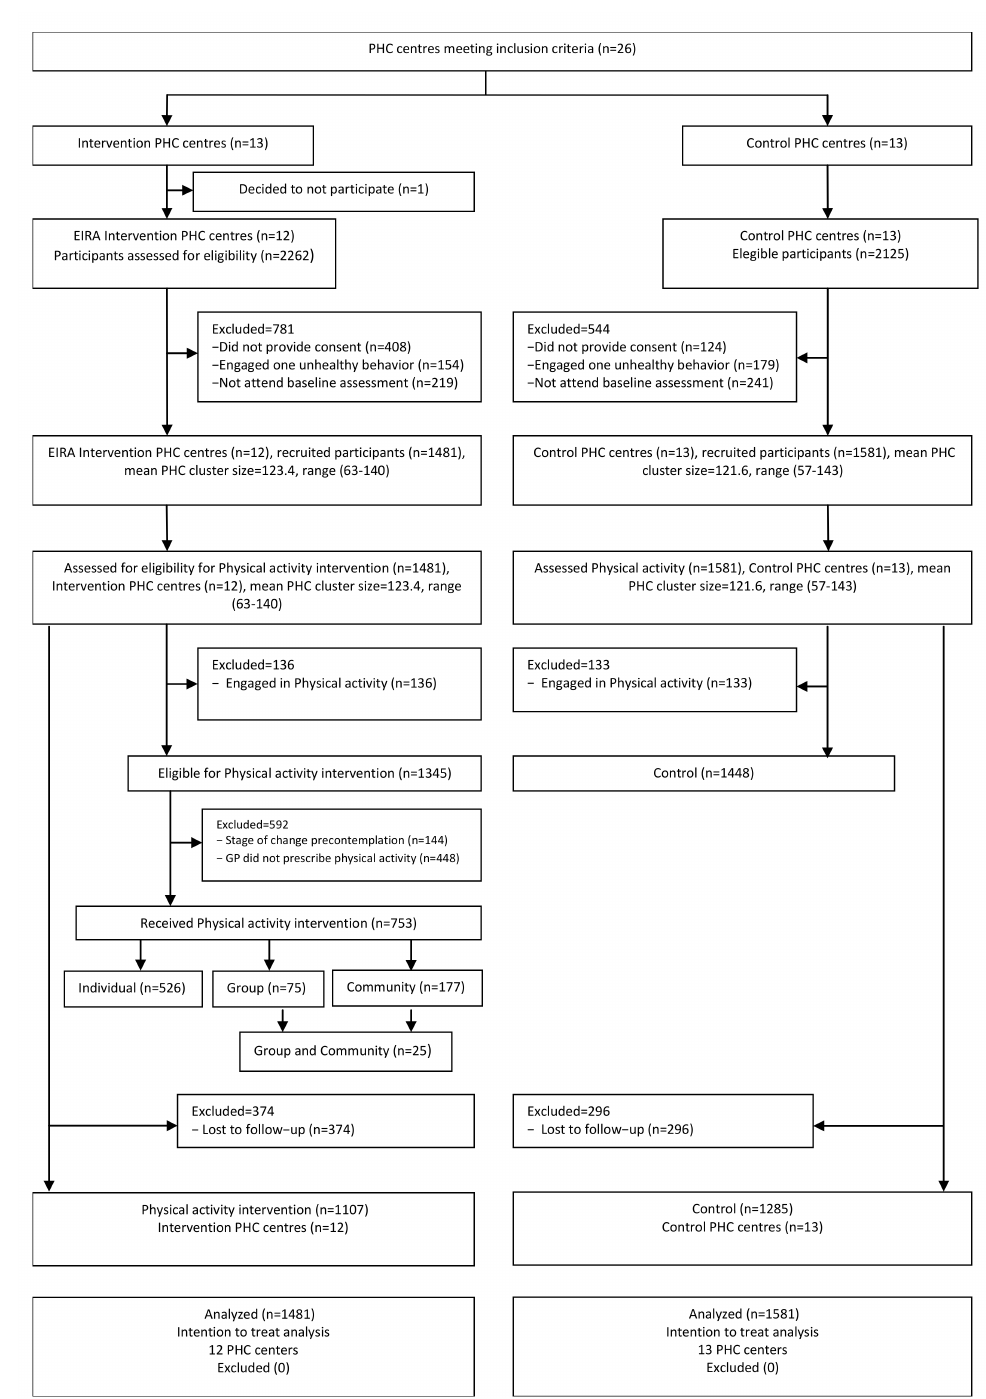
Figure 1. Enrolment and disposition of participants in the intervention and control